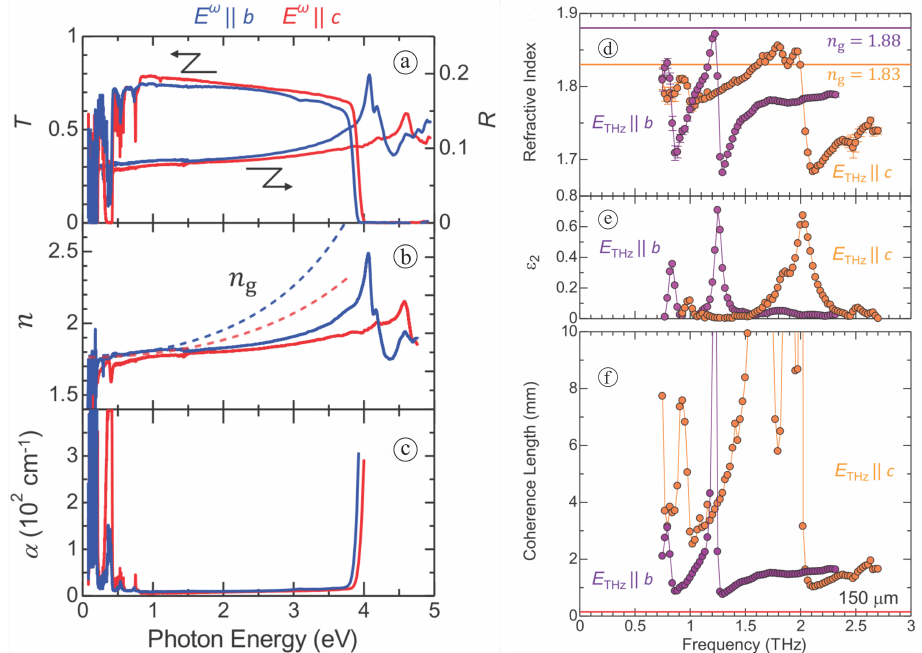
Figure 21. ( a ) Polarized transmittance T and reflectivity R , ( b ) refractive index n , and ( c ) absorption coefficient α versus photon energy for E ω || b (blue (gray) lines) and E ω || c (red (light gray) lines). The group refractive index n g spectra are also shown by the dotted lines in ( b ). ( d ) Refractive index and ( e ) imaginary part of the dielectric constant (cid:101) 2 versus THz frequency along the b and c axes. ( f ) Calculated coherence length along the b and c axes, which exceeds the sample thickness (150 µm, indicated by the horizontal red (gray) line) used in the THz radiation experiments. Reprinted with permission from [227]. Copyright 2022 by the American Physical Society.